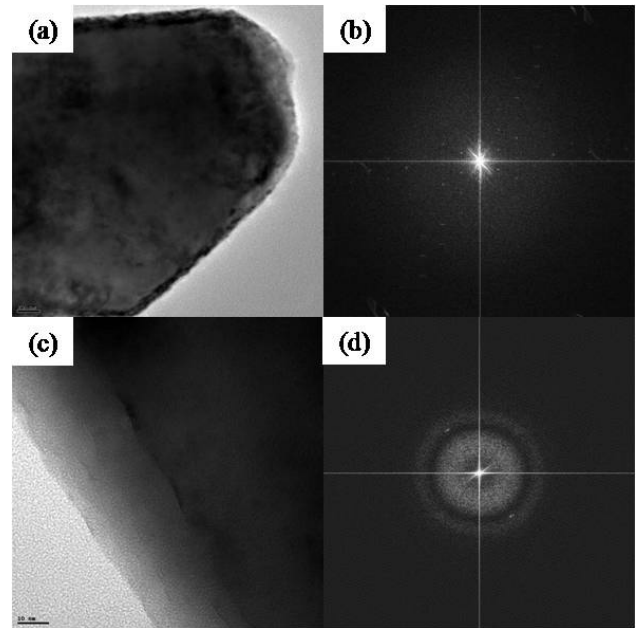
Figure 7. HRTEM and corresponding FFT of aragonite surface. (a) HRTEM image and (b) corresponding FFT before the dissolution of aragonite, and (c) HRTEM image and (d) corresponding FFT After the